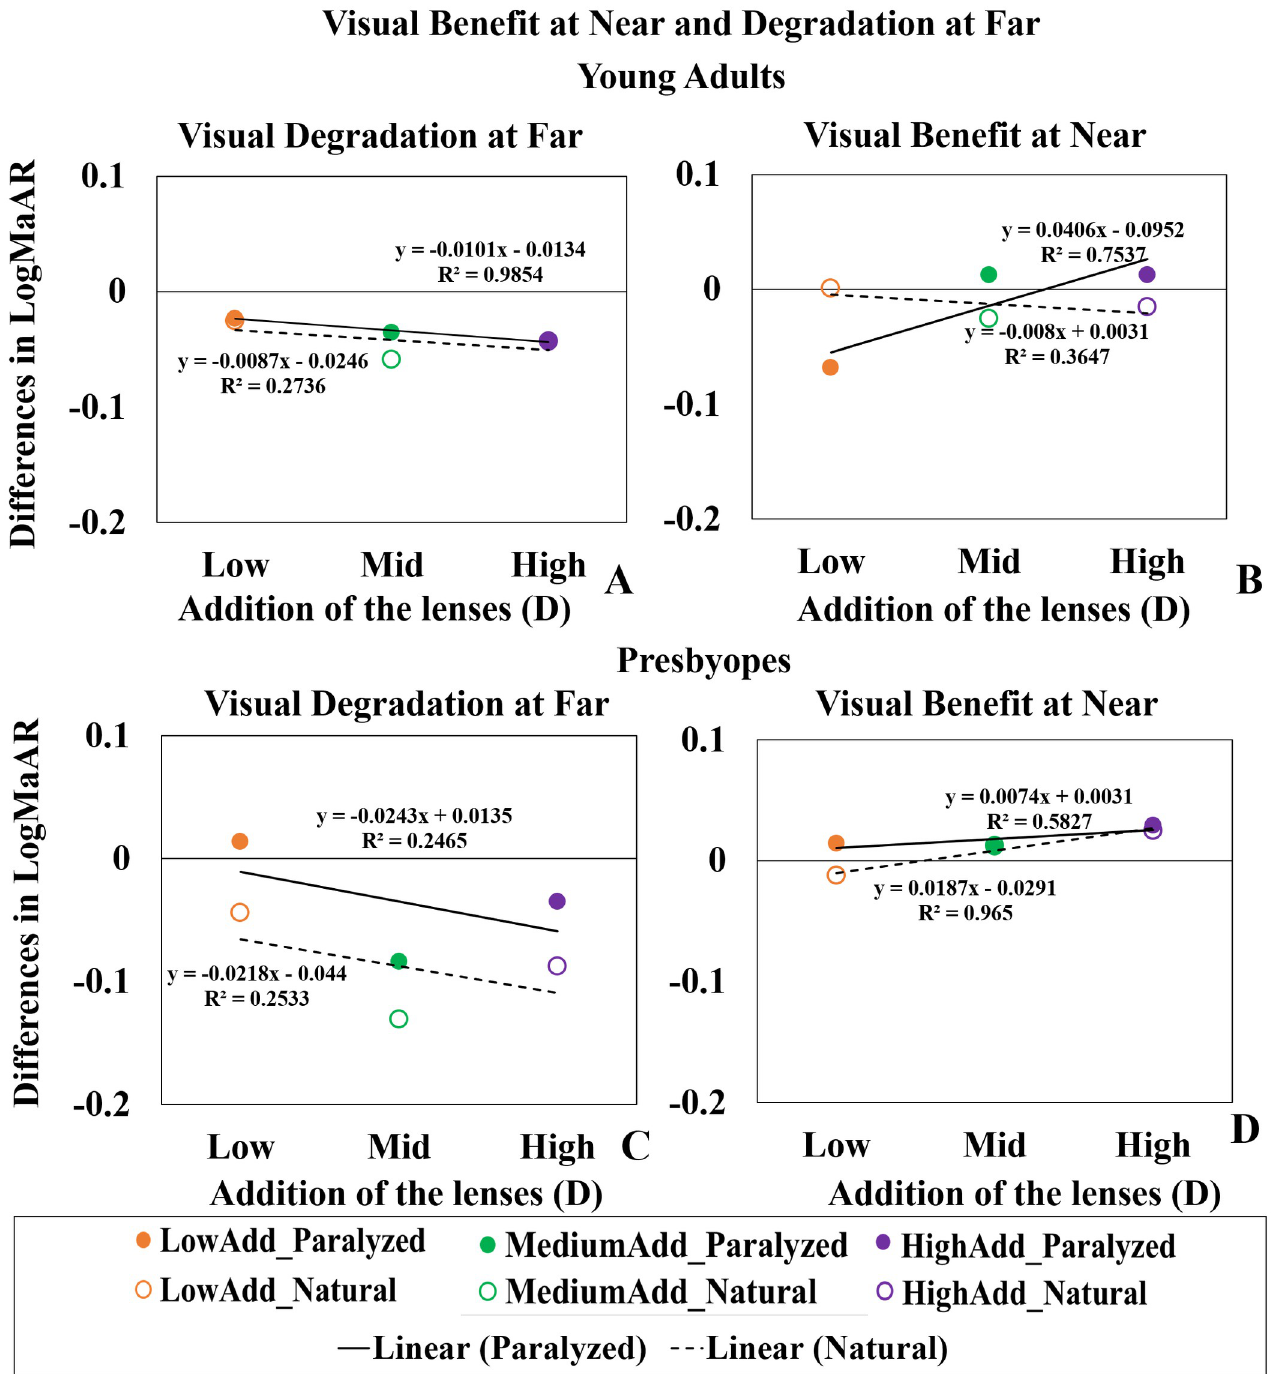
Fig 8. Visual benefit and visual degradation at far. (A), (C) Visual Degradation at far (left panels) and (B), (C)Visual Benefit at near (right panels) in young adults (upper panels) and presbyopes (lower panels), estimated as differences of logMAR VA with the MCLs and NoLens, averaged across subjects. Lens condition is identified by color—Orange: LowAdd; Green: MediumAdd; Purple: HighAdd. Accommodation condition is identified by fill pattern (solid symbols: paralyzed accommodation; open symbols: natural accommodation). Regression lines are shown as black solid lines for the paralyzed condition and dashed lines for the natural accommodation